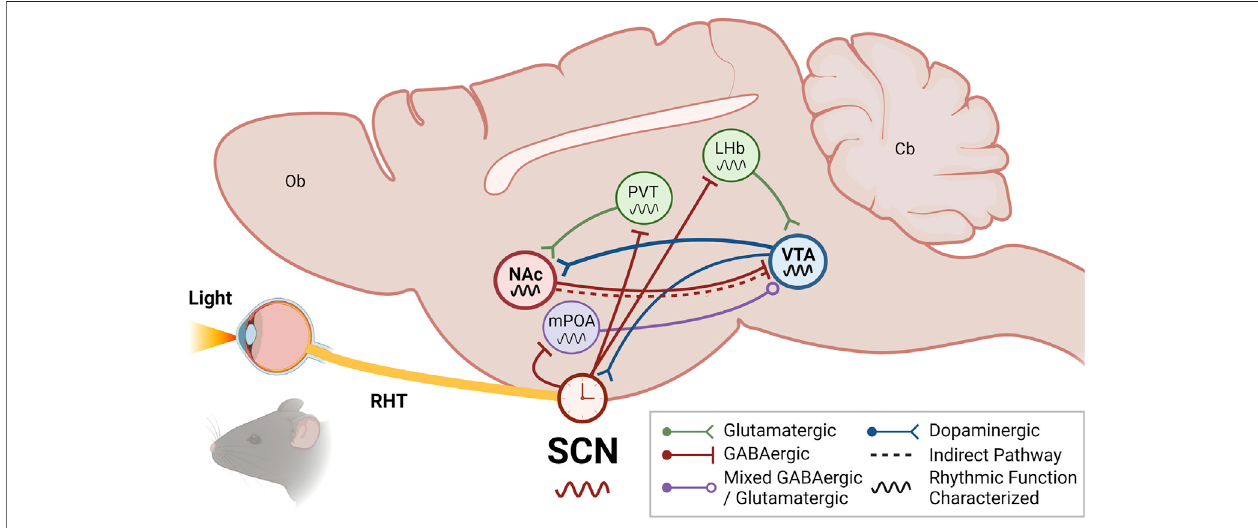
FIGURE 2 | The VTA and NAc are integrated into the circadian system through indirect SCN input. The suprachiasmatic nucleus (SCN) of the anterior hypothalamus receives photic information from intrinsically photosensitive retinal ganglion cells (ipRGCs) in the retina via the retinohypothalamic tract (RHT). While the SCN generates rhythms through its highly coupled network of neuronal and glial oscillators, the SCN rhythms are entrained to environmental light/dark cycles by retinal photicinformation.TheSCNsynchronizesextra-SCNoscillatorsthroughouttheorganism, bothcentrallyandperipherally, via autonomic,metabolic,and hormonal signals.Theseextra-SCN oscillatorsarethoughttoafford localtemporal controlofcomplexphysiology andbehaviors.Inparticular,theventral tegmental area(VTA) and nucleus accumbens (NAc) of the mesolimbic pathway may receive and integrate circadian information through indirect connections with the SCN. In addition to reciprocally communicating with the NAc through direct and indirect projections to mediate reward, the VTA may receive indirect SCN circadian input via the lateral habenula (LHb) and/or the medial preoptic area (mPOA) — both of which are direct outputs of the SCN and also receive photic information from ipRGC innervation. Notably, the VTA has also been shown to directly innervate the SCN and regulate photoentrainment. The NAc may receive indirect SCN circadian input via the paraventricular nucleus of the thalamus (PVT), one of the densest extrahypothalamic outputs of the SCN, or via the VTA. Schematic illustrates a sagittal section of a rodent brain. Unde fi ned: olfactory bulb (Ob); cerebellum (Cb); See key for more details. Figure created with BioRender.com.